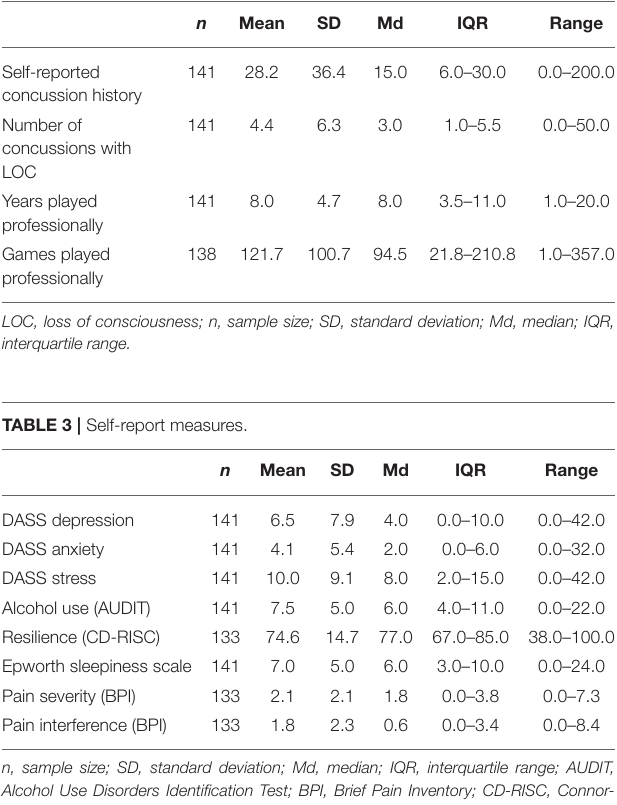
TABLE 2 | Self-reported exposure history.